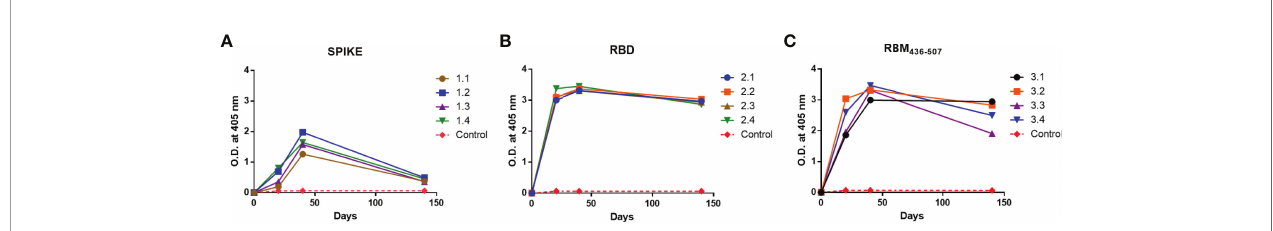
FIGURE 2 | Immunogenicity of S, RBD and RBM 436-507 in mice. Analysis of the antibody response in mice immunized at days 0, 20, 40. (A) Anti-S, (B) Anti-RBD and (C) Anti-RBM 436-507 . SD is < 20% of the mean.